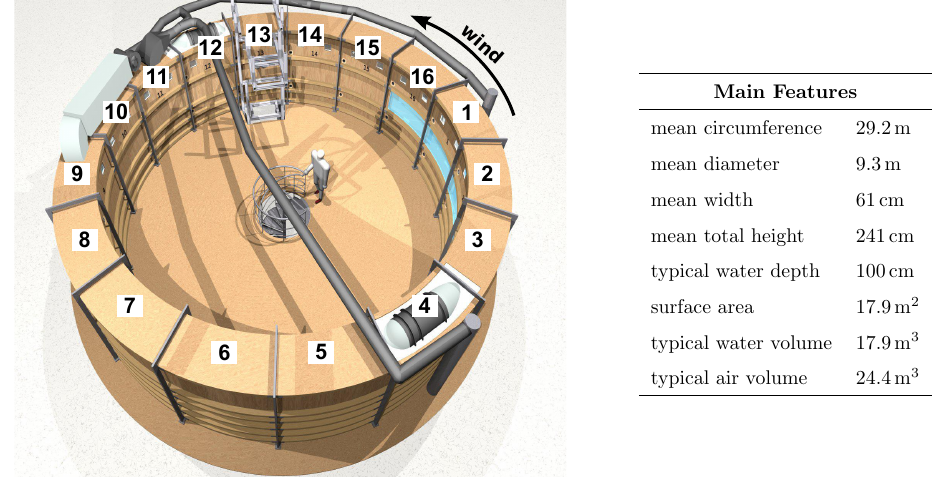
Figure 3. An aerial illustration of the Aeolotron tank and its main features. The numbers denote the segments. The axial fans producing the wind can be seen in the roof of segments 4 and 12. The air pipes supplying fresh air and removing waste air are shown in grey; figure adapted from (Krall,